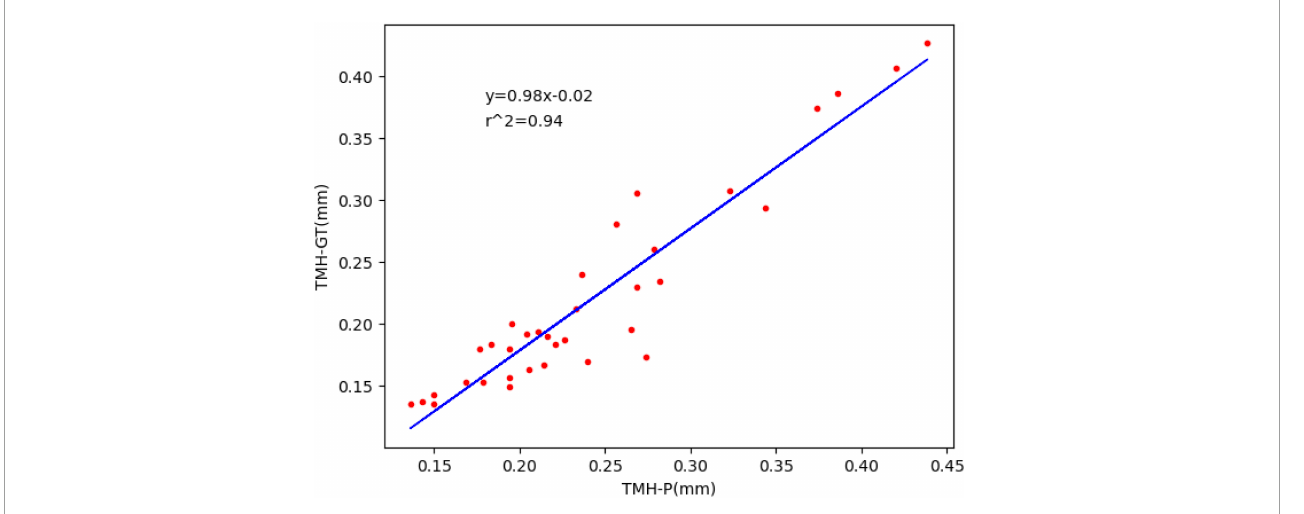
FIGURE9 Fitted linear regression of true value and predicted value of TMH; ordinate represents the true value of TMH, abscissa represents the predicted value of TMH, and the blue line corresponds to regression line y = 0 . 98x − 0 . 02 , r 2 = 0 . 94.